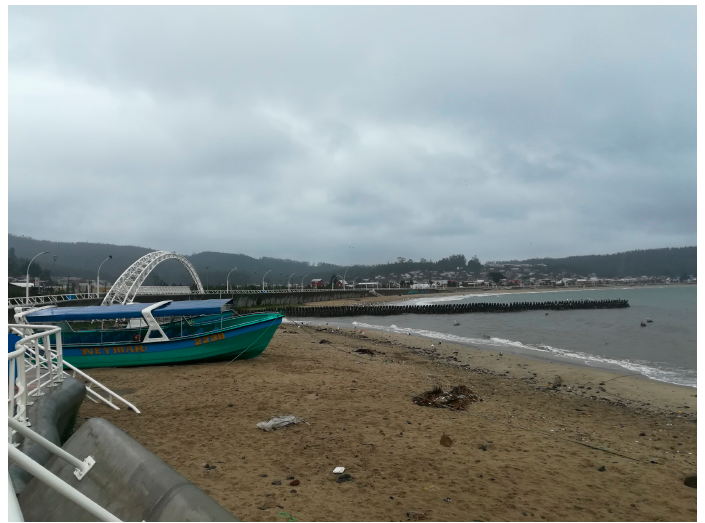
Figure 10. Layer 1 measures in Dichato. Seawall at the end of the beach. Geosciences 2018 , 8 , x FOR PEER REVIEW